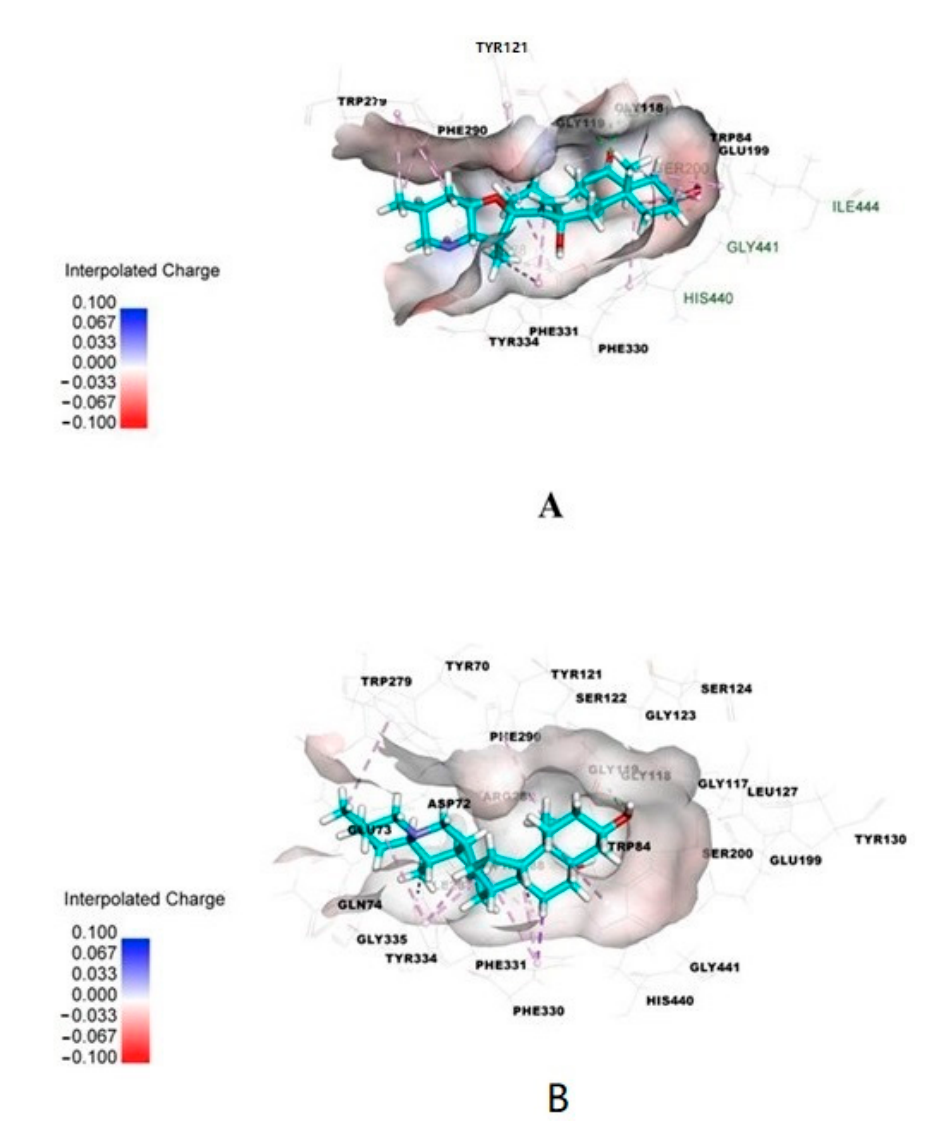
Figure 3. Molecular docking results: ( A ) walujewine (cyanic sticks) in complex with acetylcholinesterase (gray fragments); ( B ) tortifoline (cyanic sticks) in complex with acetylcholinesterase (gray fragments). Reprinted with permission from Ref. [28]. Copyright 2021